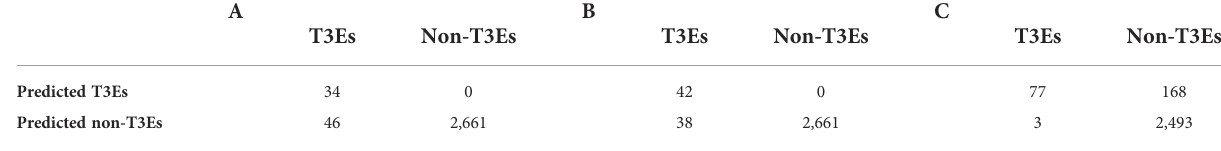
TABLE 5 The effect of including a novel feature that quanti fi es the strength of the secretion signal on the performance of